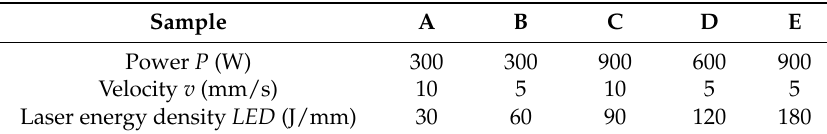
Table 1. The process parameters of different samples.